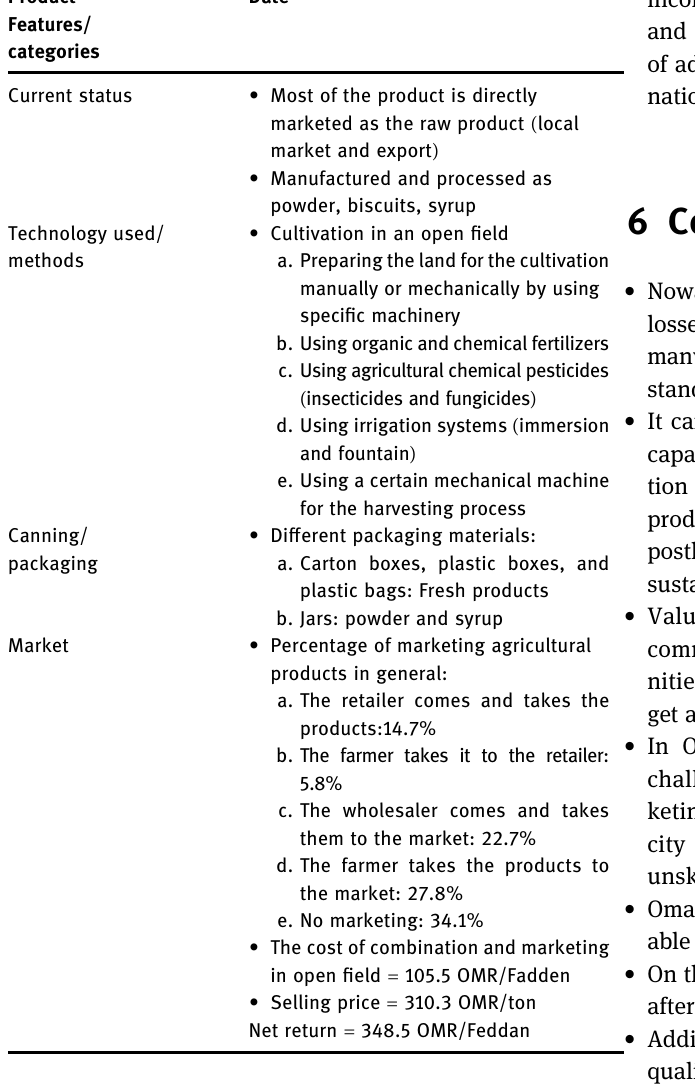
Table 8: Potential of date in achieving sustainability level [ 53,55